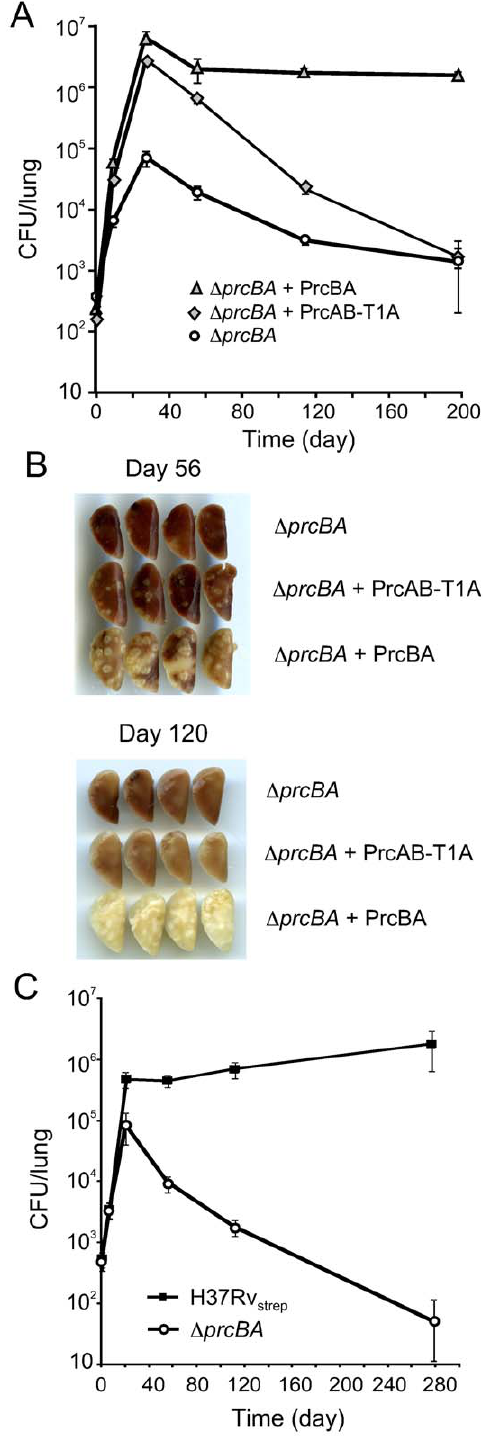
Figure 5. The active site mutant proteasome complements the in vivo growth defect but not the persistence defect of the proteasome KO. ( A ) Bacterial titers in lungs of C57BL/6 mice infected by aerosol with D prcBA and D prcBA complemented with wild type and the active site T1A mutant ptroteasome. Data are means 6 s.d. from four mice per time point per group and represent two independent experiments. ( B ) Gross pathology of lungs infected with D prcBA and D prcBA complemented with the wild type and the active site mutant proteasome at day 56 and day 120 post-infection. ( C ) Bacterial titers